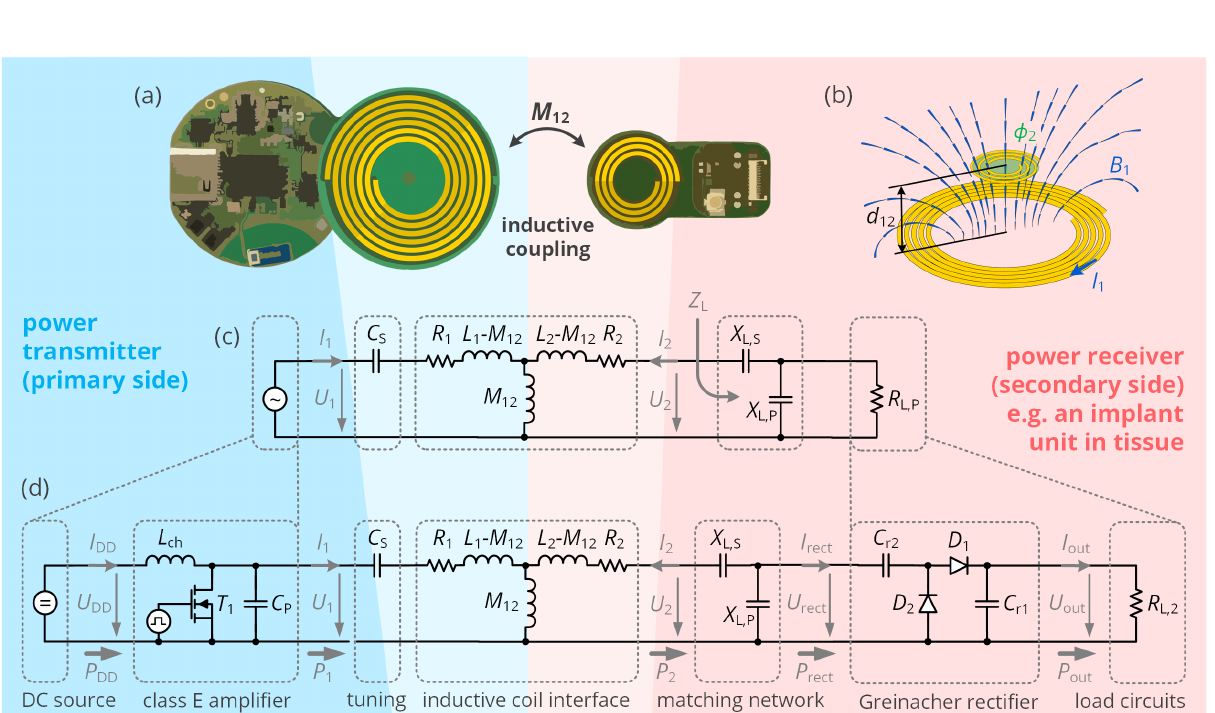
Figure 1. An inductive link for wireless power transfer to a low-power circuit, such as a biomedical implant. ( a ) Physical setup: A primary coil of inductance L 1 and resistance R 1 inductively couples to a secondary coil of inductance L 2 and resistance R 2 by a mutual inductance M 12 . ( b ) Illustration of the magnetic flux density distribution B 1 due to the current I 1 and the magnetic flux φ 2 through coil 2. The mutual inductance is defined as M 12 : = φ 2 / I 1 . ( c ) Simple equivalent circuit of the wireless power transfer interface: The inductive coil interface is represented by a T equivalent circuit, the implant AC load resistance R L,P is matched to the secondary coil by a capacitive L matching network. On the primary side, a series capacitance C S (partially) compensates the reactance of L 1 to allow for increased input power levels. ( d ) Extended equivalent circuit of the wireless power transfer interface: The primary voltage source is replaced by a DC source and a class E amplifier to drive the coil, as well as a Greinacher rectifier (voltage doubler) and a resistive DC load R L,2 , summarizing voltage converters and the load circuitry